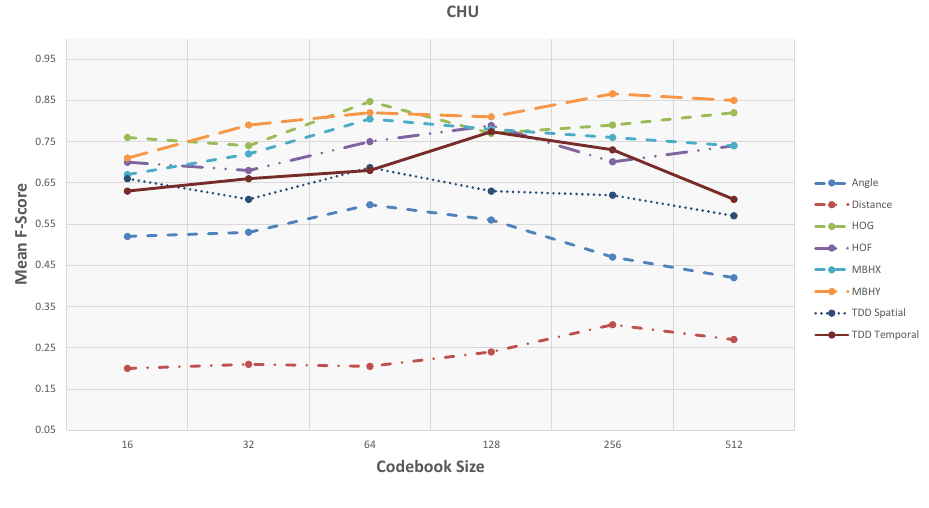
Figure 9. Shows F-Score values of the unsupervised framework w.r.t. codebook size on CHU dataset.